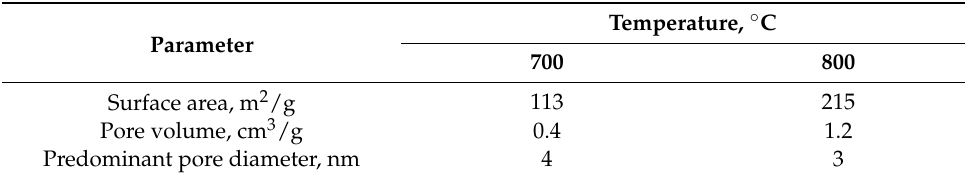
Table 7. Porous structure of the synthesized samples at the initial content of NH 3 = 50% vol. and different